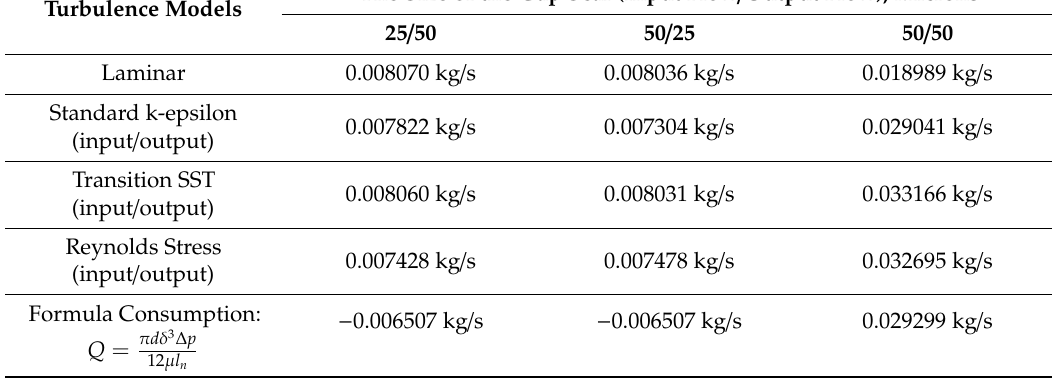
Table 2. Volume flow through a gap defined by di ff erent flow models for di ff erent sizes of gap seals for laminar flow.